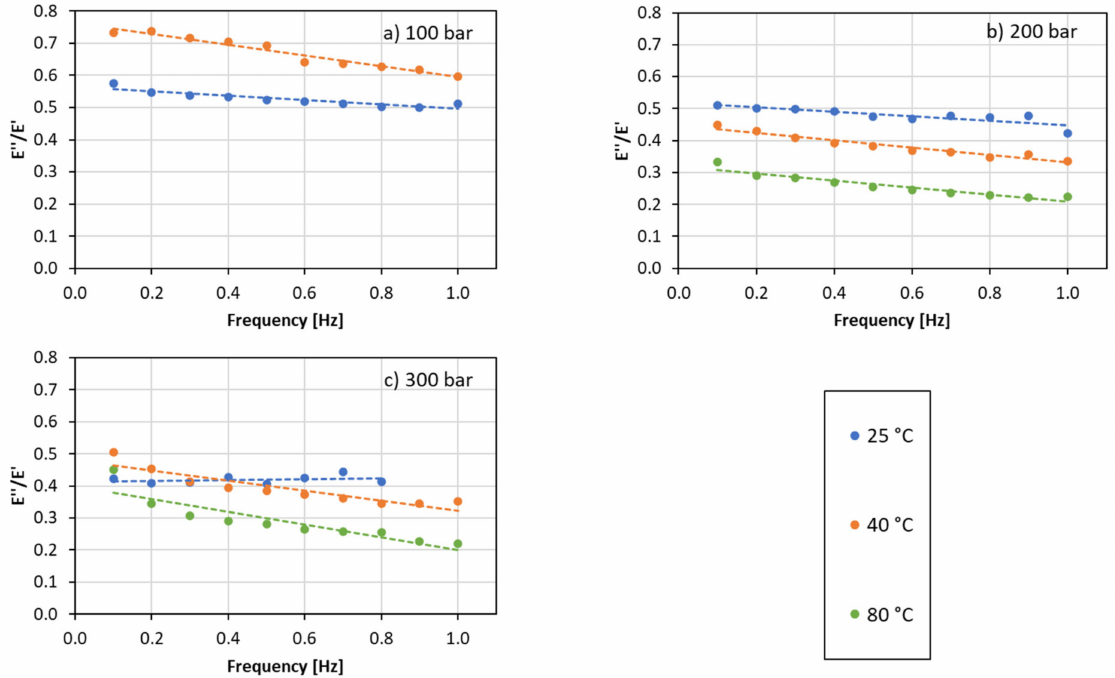
Figure 6. E ”/ E (cid:48) ratio for systems from 25 to 80 ◦ C at pressures of ( a ) 100 bar, ( b ) 200 bar and ( c ) 300